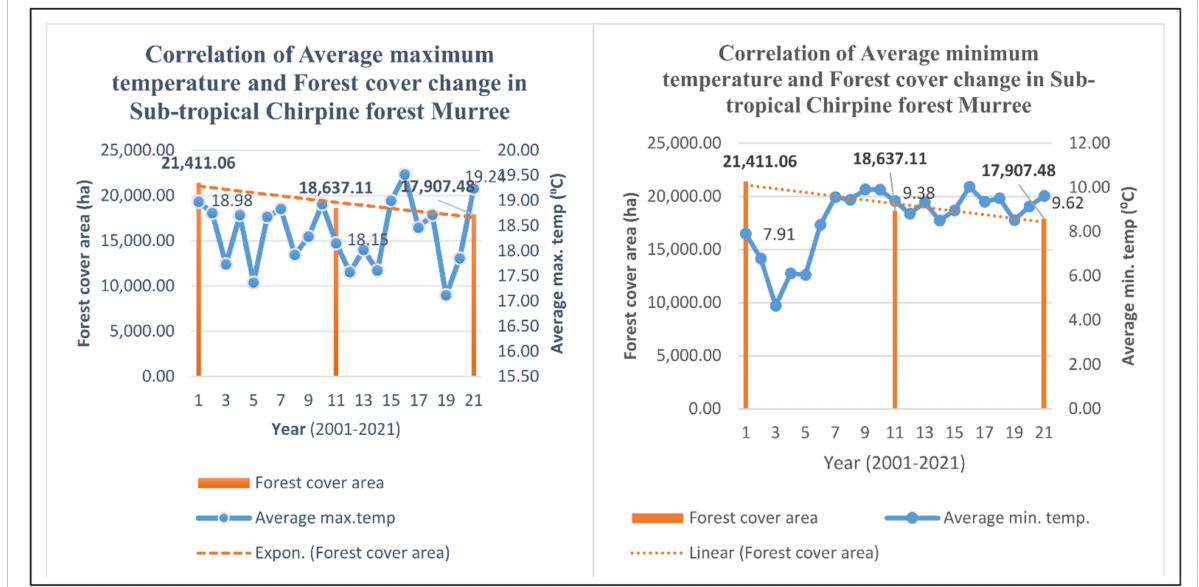
Figure 8. Graphical representation of correlation of average maximum and minimum temperature and forest cover change in subtropical Chir pine forest, Murree.